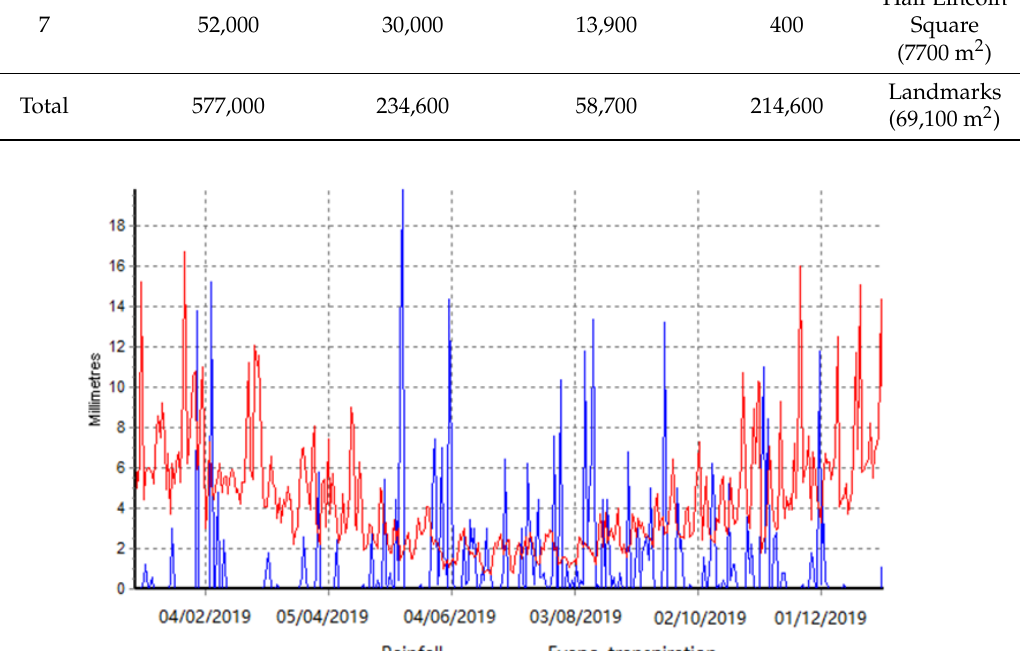
Figure 2. Meteorological data (rainfall and evapotranspiration) from Flemington station and Melbourne Airport station.